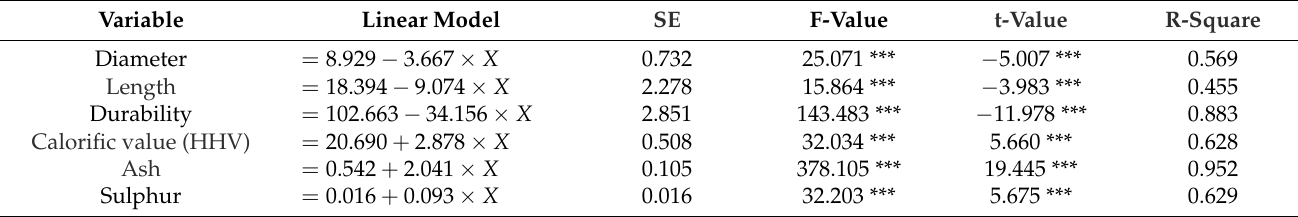
Table 6. Linear regression analysis of pellet properties depending on SCG blending